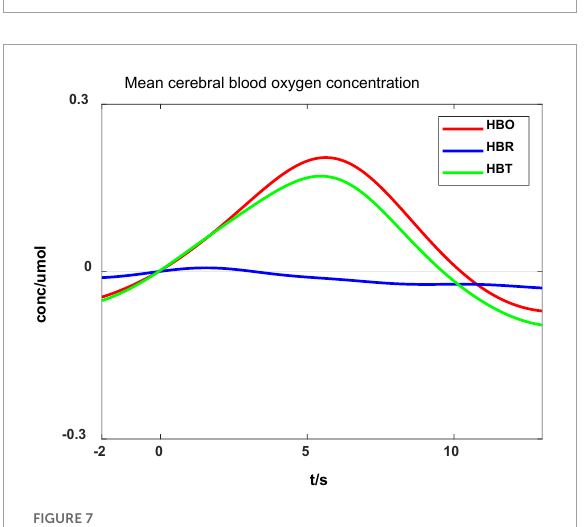
FIGURE7 Cerebral blood oxygen concentration during ankle flexion.